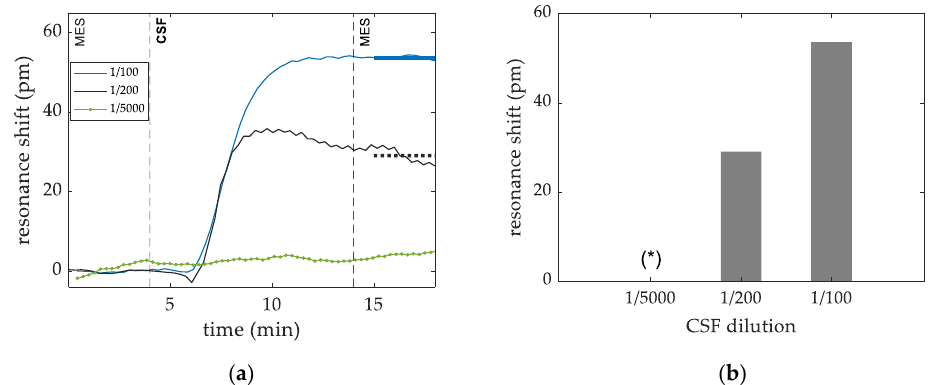
Figure 6. ( a ) Dose dependence signal shift (measured in pm) for pAb (alpha diagnostic) for each CSFV dilution tested. The detection level for each dilution was obtained as the average shift of the data acquired after the rinsing step and depicted as a horizontal line. ( b ) The detection levels for each dilution tested are summarized in a bar chart. For the highest dilution, quantification of the detection level it is not feasible, and this is marked with an (*).